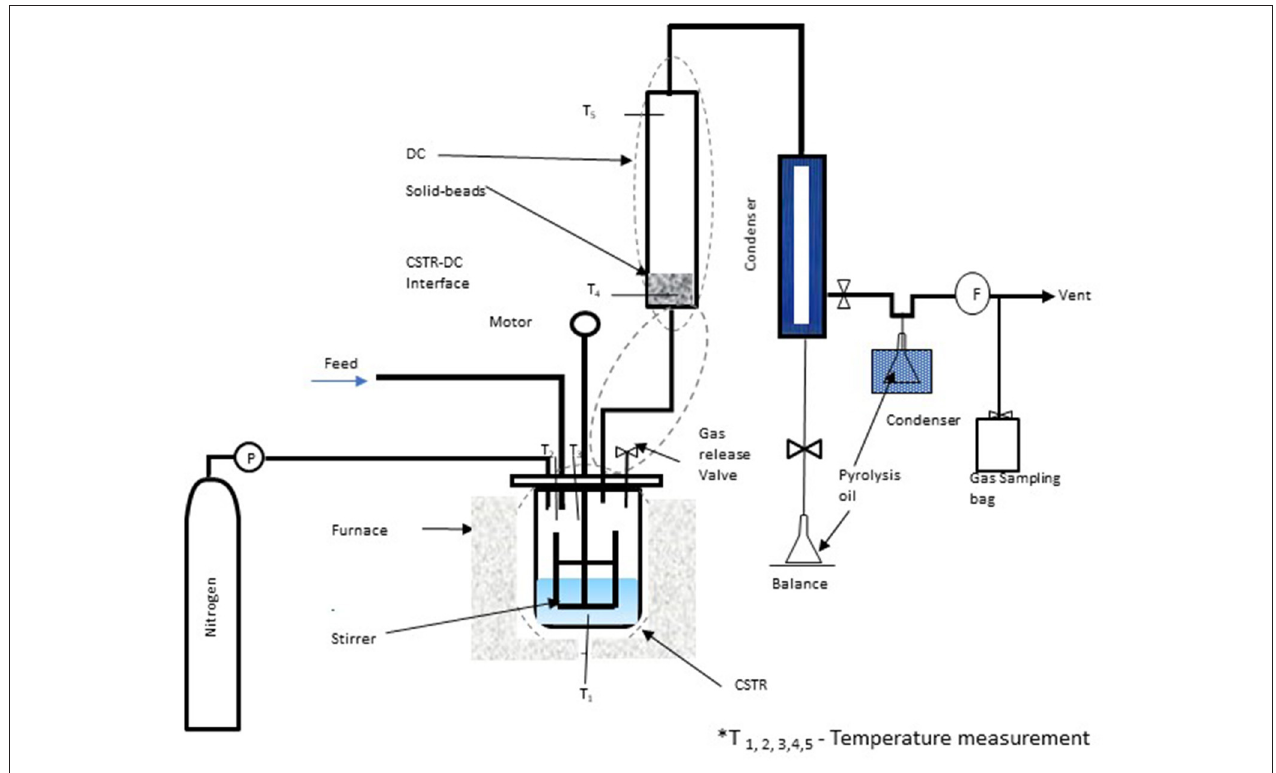
FIGURE 1 | Schematic diagram of CSTR- DC pyrolysis reactor for pretreated ASR (Auxilio et al., 2017).